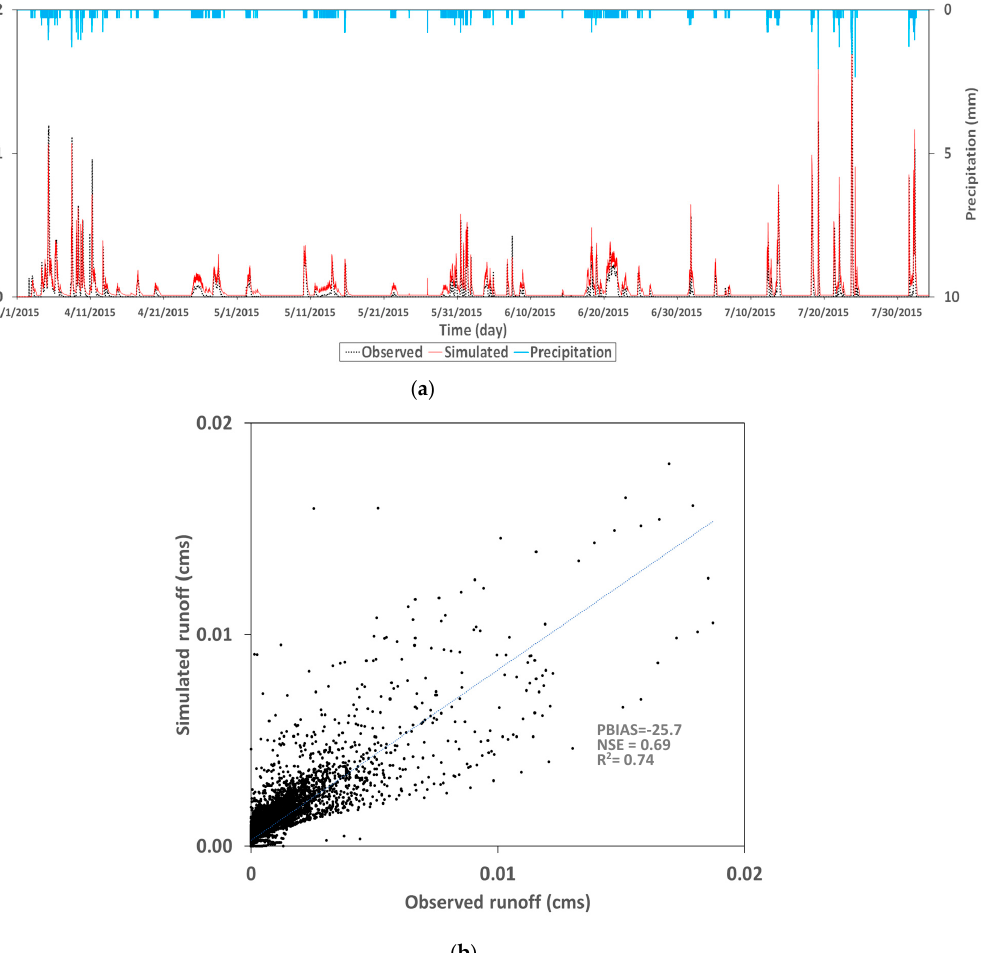
Figure 11. ( a ) Comparison of observed and simulated runoff for a small parking lot ( b ) Scatter diagram of observed and simulated data.